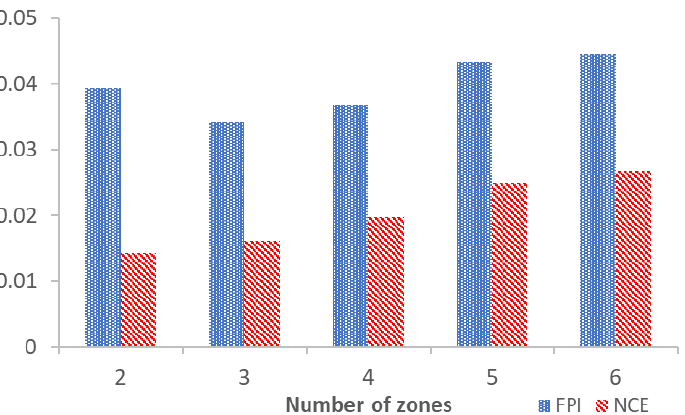
Figure 5. Diagram of the fuzziness Performance Index (FPI) and Normalized Classification Entropy (NCE) for delineating the orchard into 2 – 6 management zones.